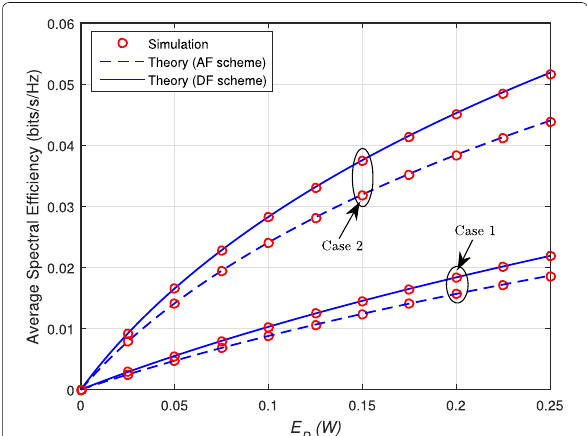
Fig. 7 Average SE versus E D (W) in case 1 and case 2 at UE2